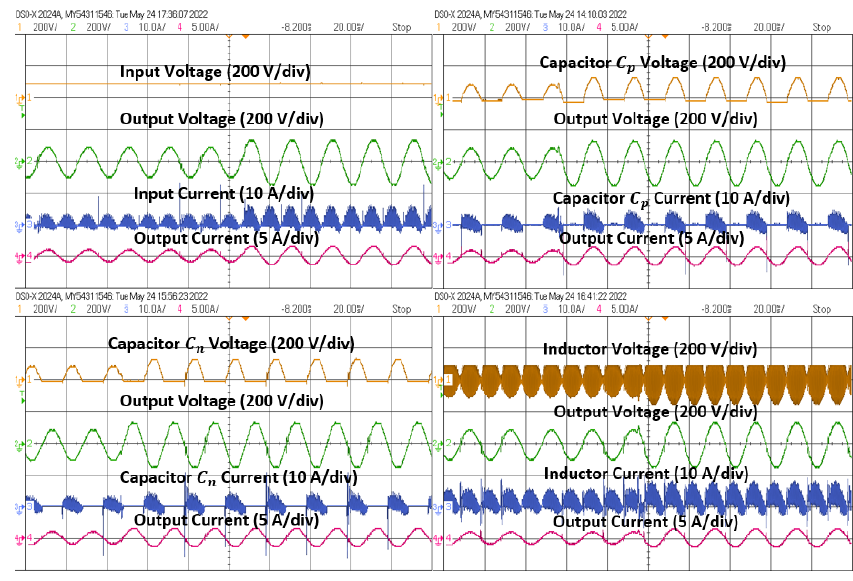
Figure 11. Transient response of mode 3 from G = 1 to 1.5.